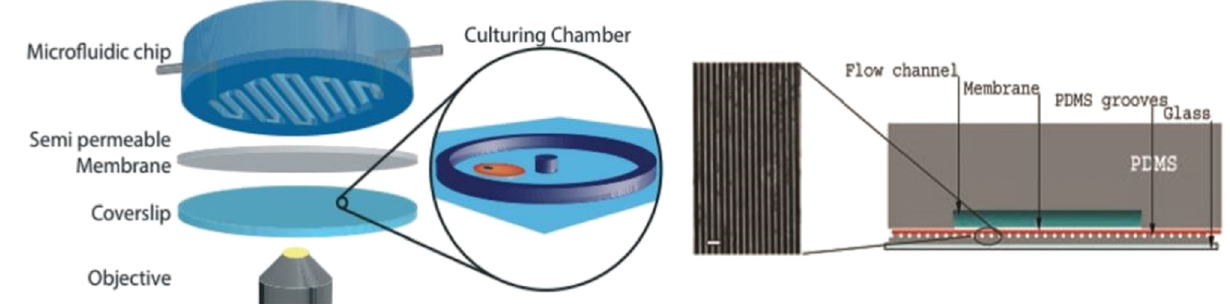
Figure 2: Micro fl uidic devices that use PDMS channels to trap cells. Left: 3D model of the micro fl uidic device from ref. [ 26 ] , showing the semipermeable membrane that covers the patterned microchambers in the coverslip. The PDMS chip di ff uses media through the mem - brane. Right: Representation of the microdevice used in ref. [ 27 ] to culture cells in PDMS grooves covered by a membrane, fed by di ff usion through a fl ow channel encapsulated in a PDMS chip. Images reproduced with permission from Lab Chip ( left, [ 26 ]) and Science ( right, [ 28 ])